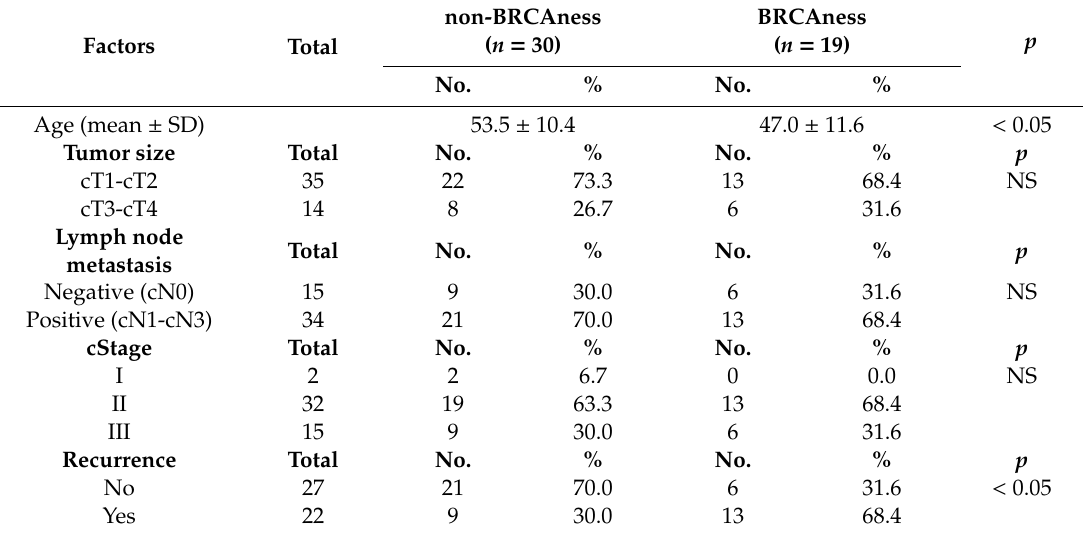
Table 3. Correlations of clinicopathologic characteristics and BRCAness in surgical